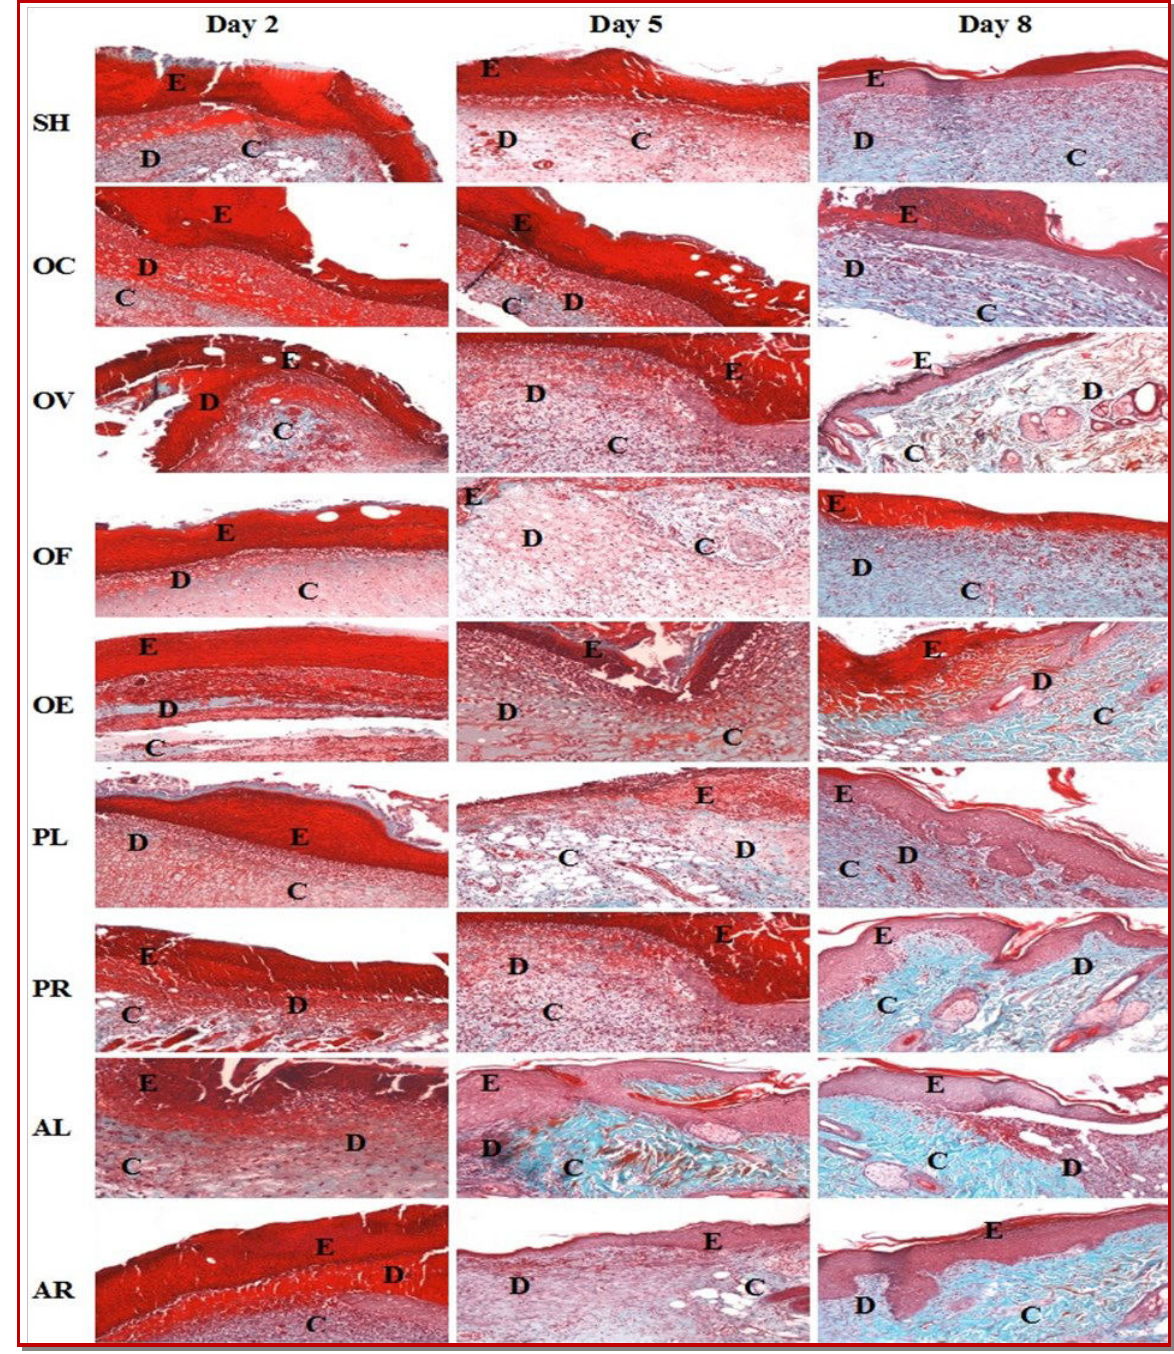
Figure 4: Histopathological view of collagen deposition in wounded skin tissue evaluated by MGT staining of nine ovariectomized female experimental groups: SH, OC, OV, OF, OE, PL, PR, AL and AR at day 2, day 5 and day 8 after the formation of the wound. Pictures of stain are at x10 magnification. Arrows pointing indicate the events during wound healing; E = Epidermis, D = Dermis and C =